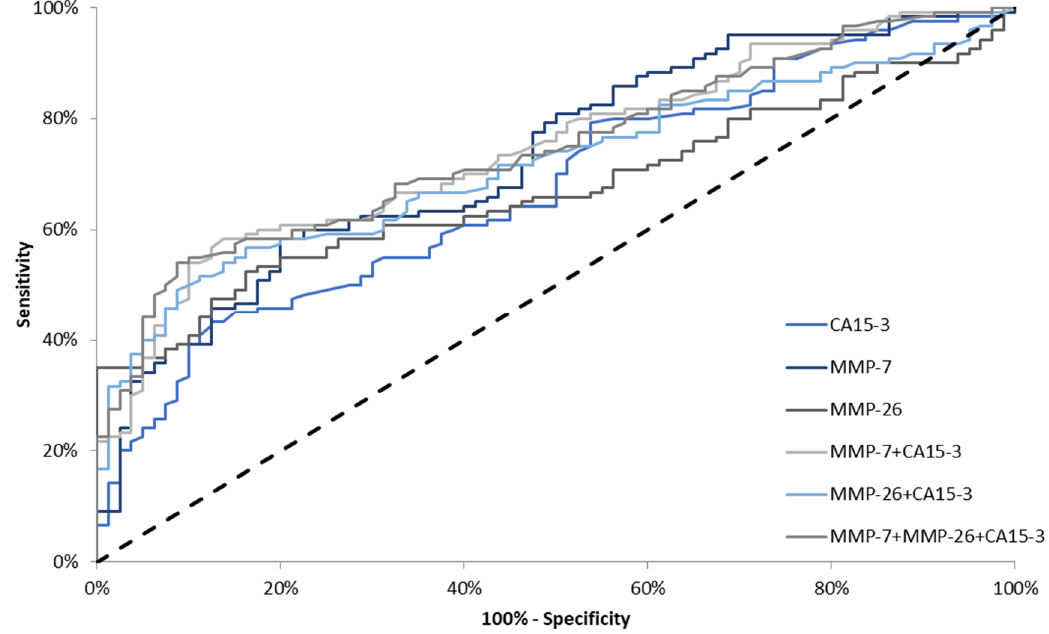
Figure 3. Diagnostic criteria of ROC curve in total breast cancer (BC) group. CA 15-3—cancer antigen 15-3; MMP-7— matrilysin-1; MMP-26—matrilysin-2.